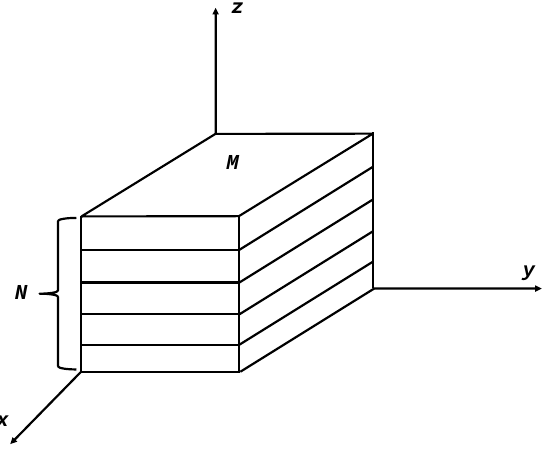
Figure 13. Division of the series-parallel structure.